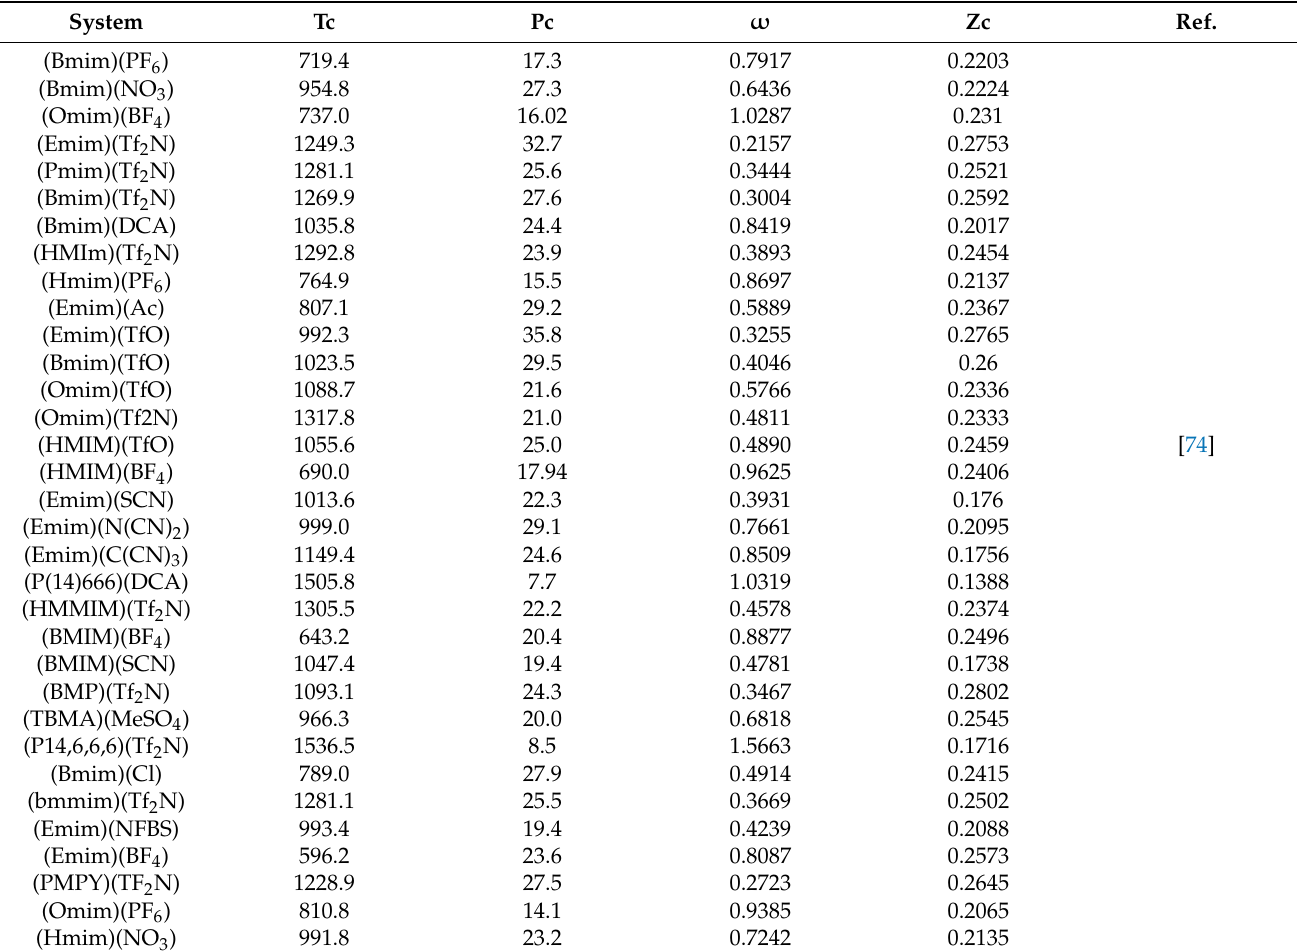
Table 5. Critical properties, acentric factors, and compressibility factors of all the substances used in this